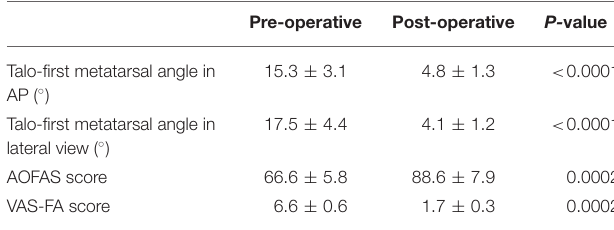
TABLE 1 | Radiographic comparison between pre-operative and last follow-up